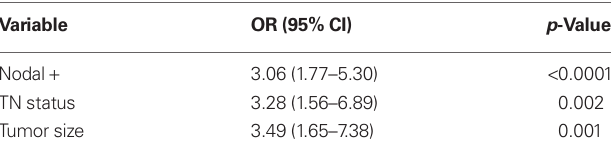
Table 5 | Multivariate analysis identifying independent risk factors for having residual disease found in the re-excision specimen after